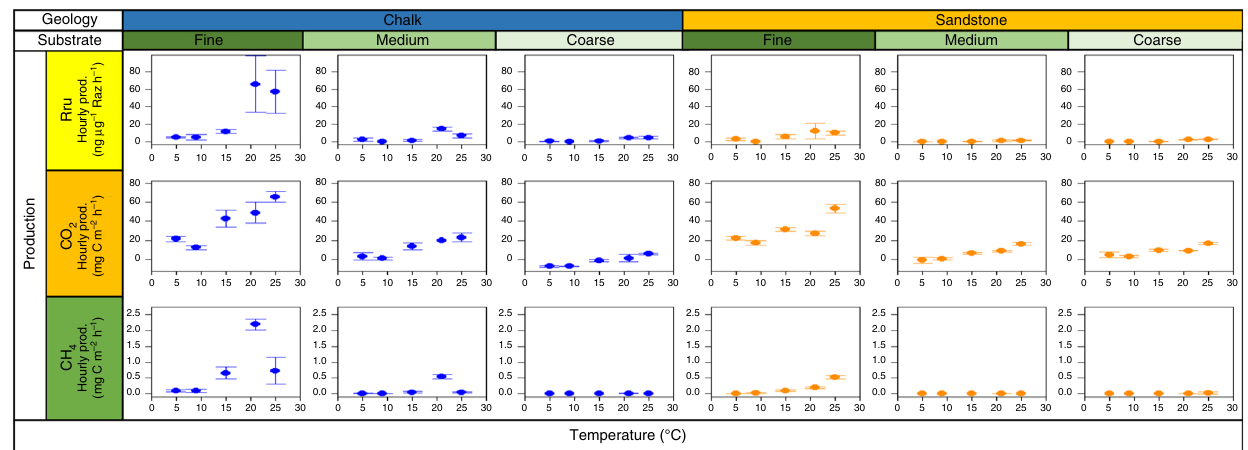
Fig. 2 The effect of temperature on microbial metabolic activity and greenhouse gas production from stream sediments. Hourly production of Resoru fi n, CO 2 and CH 4 plotted against temperature for each substrate type ( fi ne, medium and coarse) across the different geological origins (Chalk, blue, and Triassic Sandstone, orange). The error bars represent one